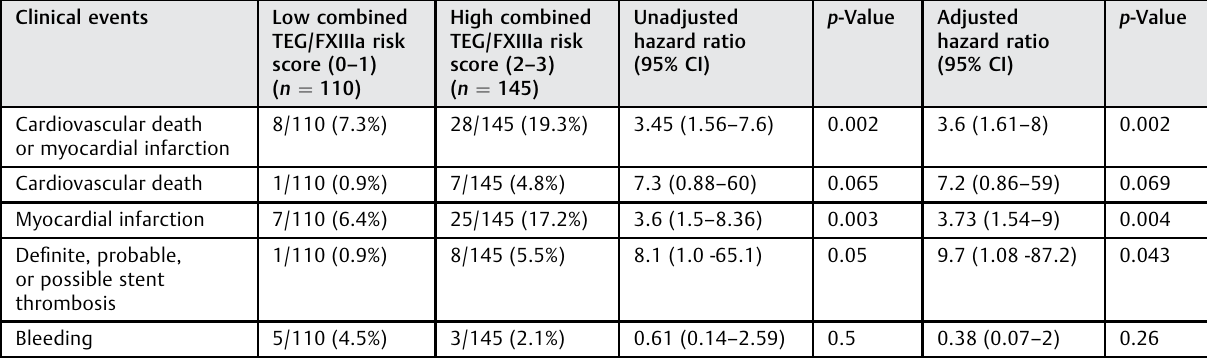
Table 6 Unadjusted and adjusted hazard ratio for clinical outcomes associated with high ( > 1) and low ( (cid:7) 1) TEG and FXIIIa risk score in Cox regression analysis Clinical